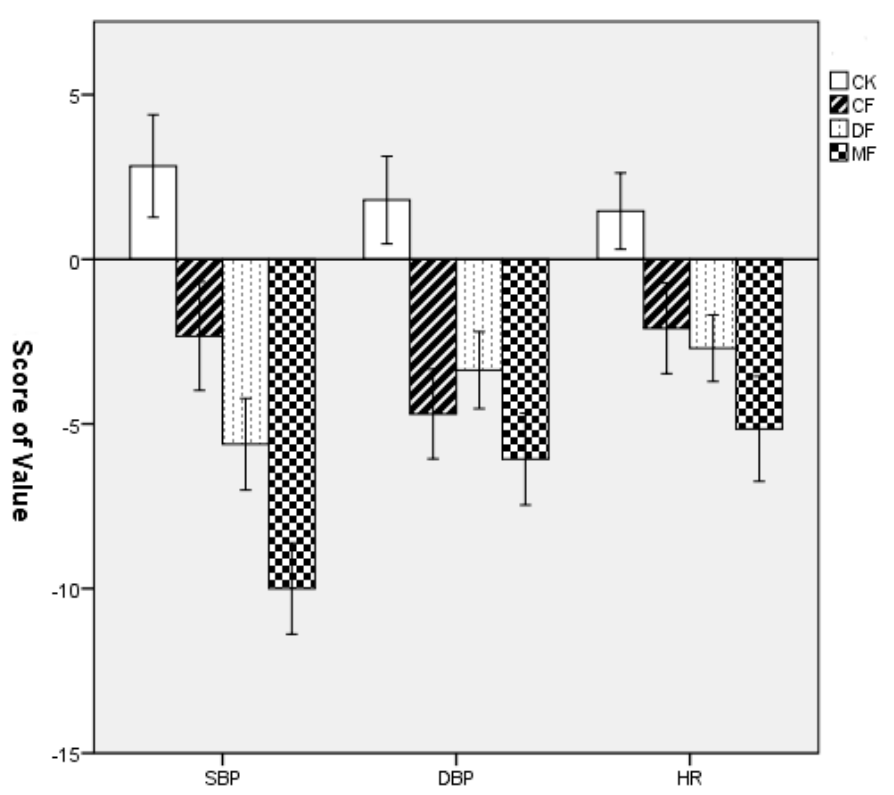
Figure 5. Comparison of reduction in values of SBP and DBP as well as HR in the four experimental sites. Data are presented as the means ± SEs. CK = urban site, CF = coniferous forest, DF = deciduous forest, MF = mixed forest.